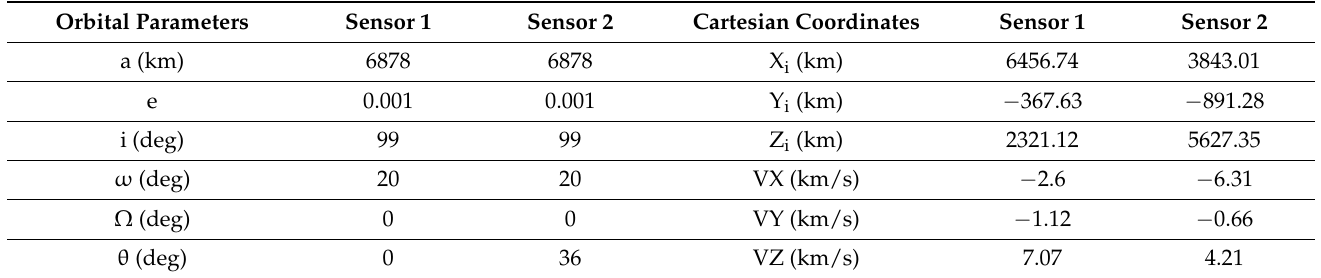
Table 4. Sensor orbital state elements.